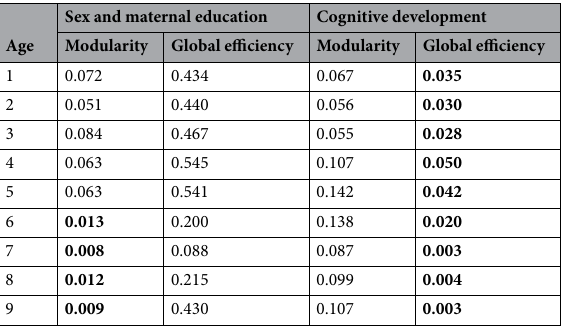
Table 1. p -values for the permutation tests assessing the sex and maternal education effects and cognitive development association with the evolution of brain region volumes based on modularity and global efficiency, where p -values less than 0.05 are emphasized in bold.